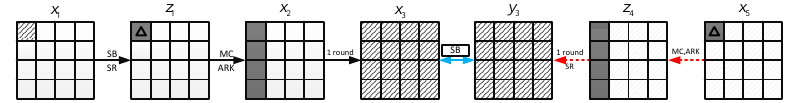
Figure 3: The truncated differential trail of 4-round AES used in [DS08], the gray cells represent 10 byte-parameters, ∆ represents difference.